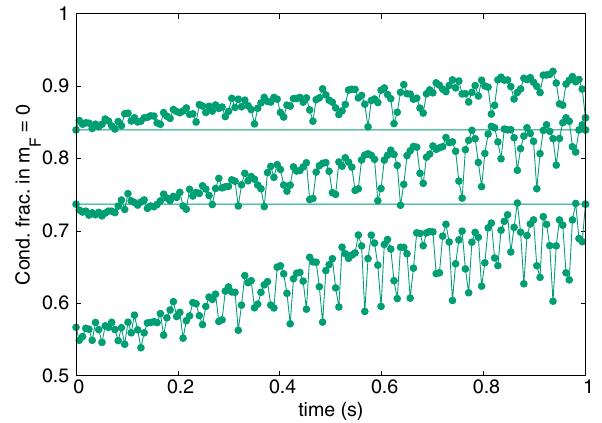
0 component as a function of time. Three sets of data =